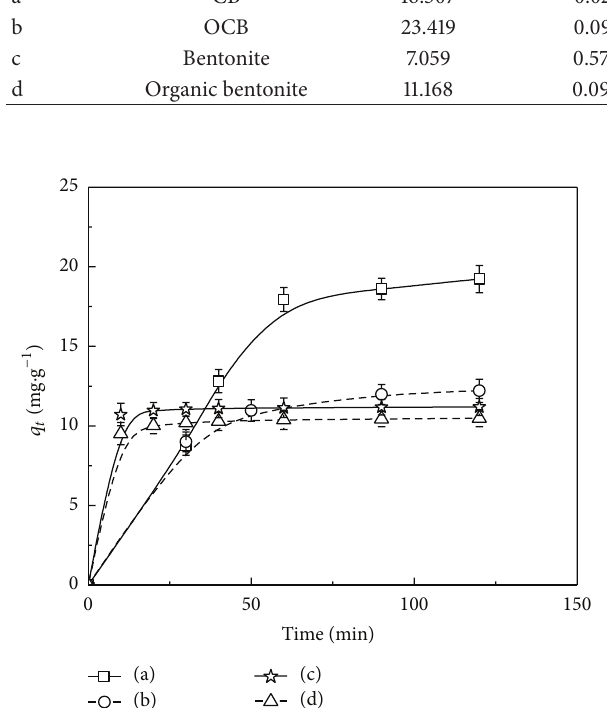
Figure 1: Adsorption kinetics for Cu 2+ adsorption on (a) OCB, (b) CB, (c) organic bentonite, and (d) bentonite as a function of reaction